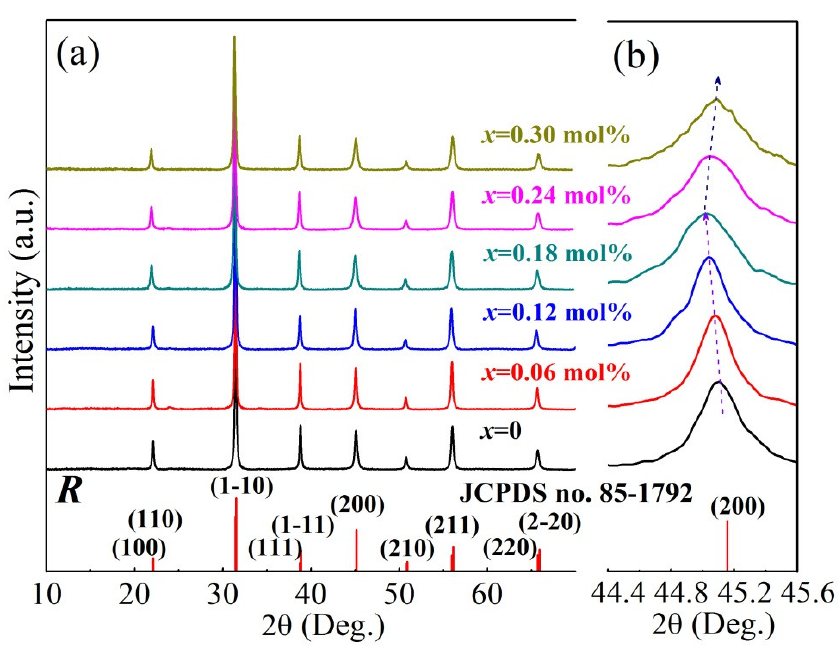
Figure 1. ( a ) XRD patterns for the BCTZ-NY x ceramics synthesized with various yttrium contents ( x ) and ( b ) selected enlarged regions of the XRD patterns. Table 1. Lattice parameters ( a , b , c , and Axial angle ) and densification (density ( ρ ) and relative den-